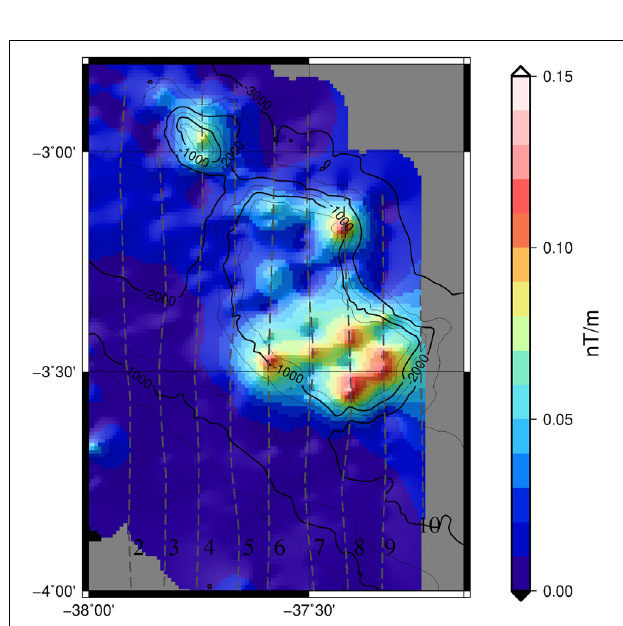
FIGURE 10 | Analytic signal amplitude of the magnetic anomaly of the Ceará Plateau.